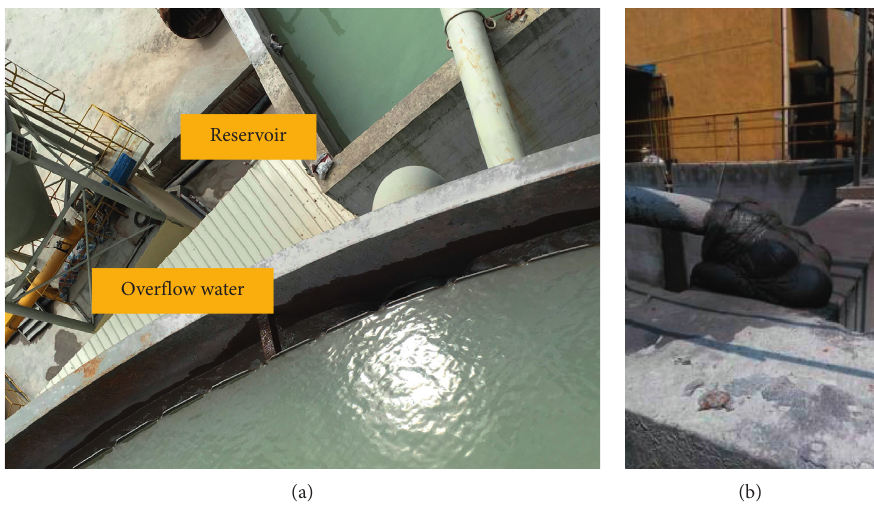
Figure 14: Overflow water (a) and underflow tailings (b) in the field